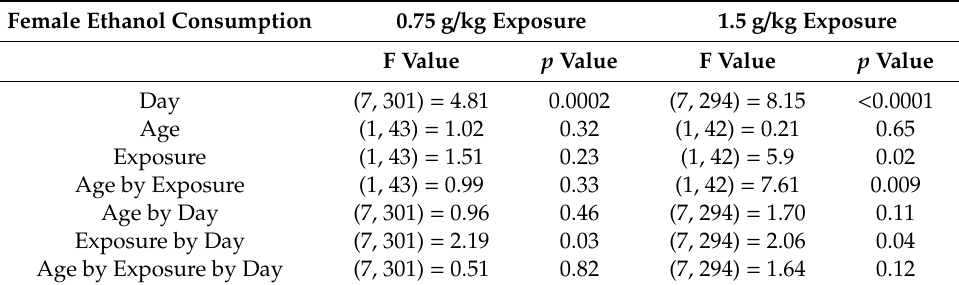
Table 1. Table for ANOVA results for female ethanol consumption data.